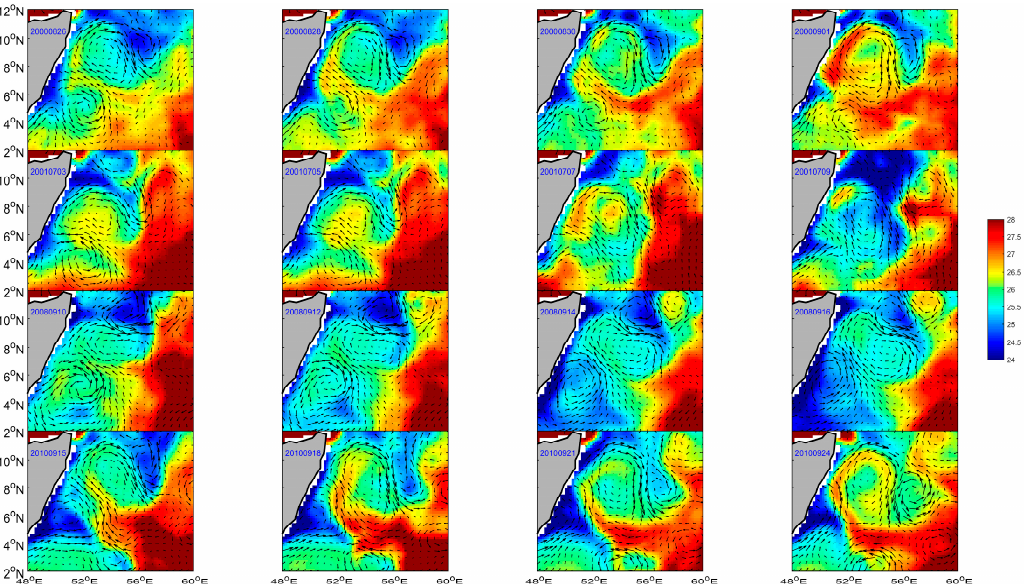
Figure 11. Evolution processes of the SST (color shadings; units: ◦ C) and flow (vectors; units: m · s − 1 ) fields near the GW. ( First row : August 2000; second row : July 2001; third row : September 2008; fourth row : September 2010).